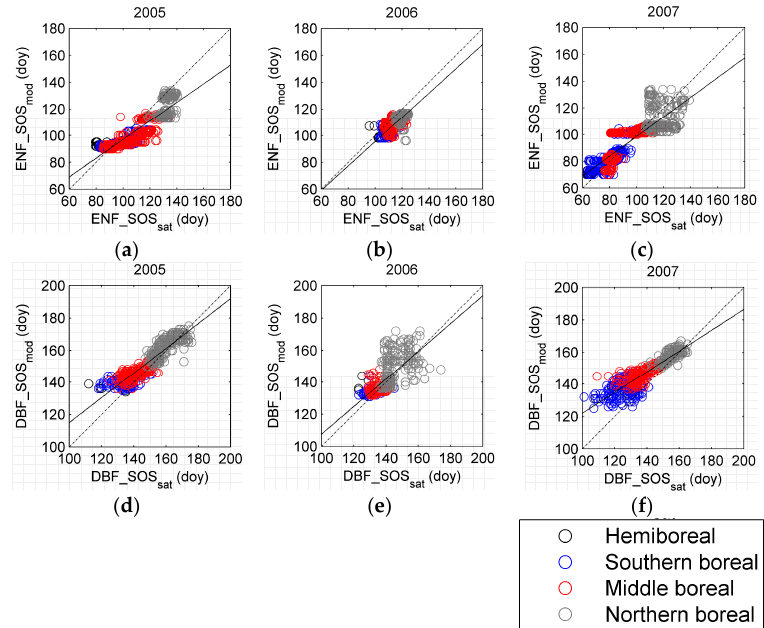
Figure 8. Grid cell-wise bias between start of season derived from the JSBACH model and remote sensing in Finland for the period 2003–2010: ( a ) in evergreen needle-leaf forest; and ( b ) in deciduous broad-leaf forest; ( c ) Bias in JSBACH-modelled starting date of the “growth phase” of DBF because of the driving temperature data. The bias was calculated as the difference in the start date of the “growth phase” simulated by running the LoGro-P-model with regional climate model data and with gridded temperature observations. Red colours show areas with a late bias and blue areas indicate an early bias of the modelled date.